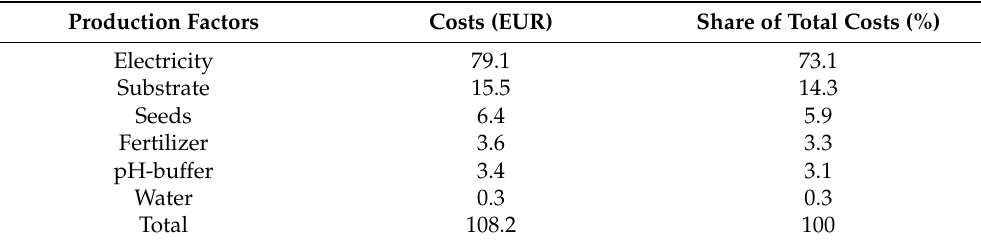
Table 13. Economical assessment (conventional energy mix): production factors, costs and their relative contribution to the total